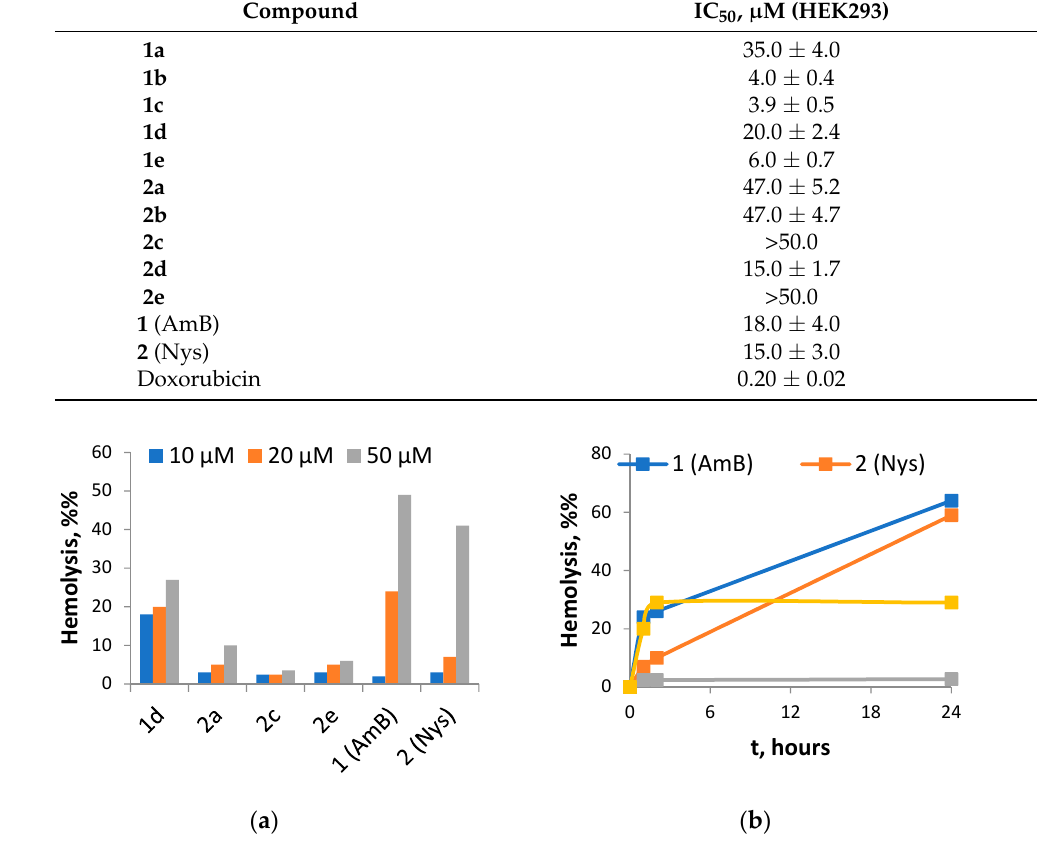
Figure 2. Hemolytic activity of selected amides of Nys and AmB: ( a ) hemolysis ratio after 1 h incubation of red blood cells with 10, 20 and 50 μ M of tested compounds; ( b ) hemolysis ratio during 24 h incubation of red blood cells with 20 μ M of tested compounds.